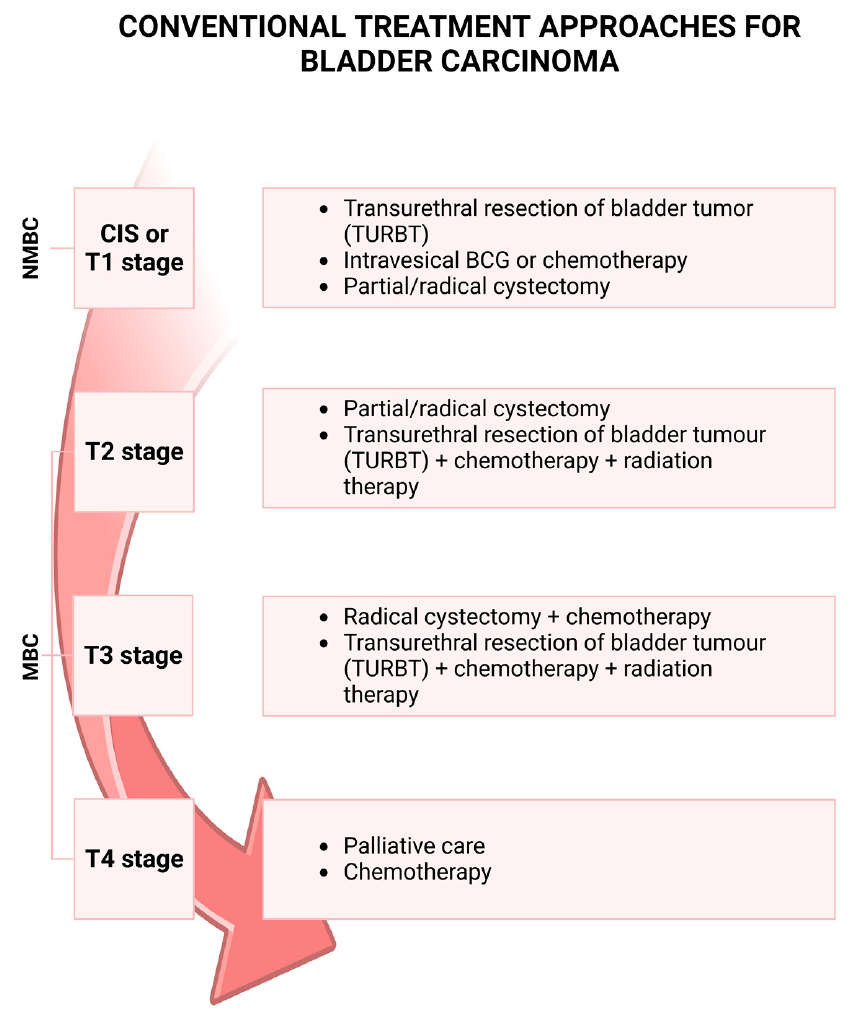
Figure 1. Bladder carcinoma progression and therapy. Non-muscle-invasive bladder cancer (NMBC), including the carcinoma in situ (CIS) or T1 stages, is treated with transurethral resection of bladder tumor (TURBT), intravesical instillation of bacillus Calmette–Guérin (BCG) or chemotherapy. Treatment for muscle-invasive bladder cancer (MBC) can be cystectomy with chemotherapy or TURBT with chemotherapy and radiation therapy. The conventional treatment for the T4 stage is chemotherapy or palliative care. Created with BioRender.com.